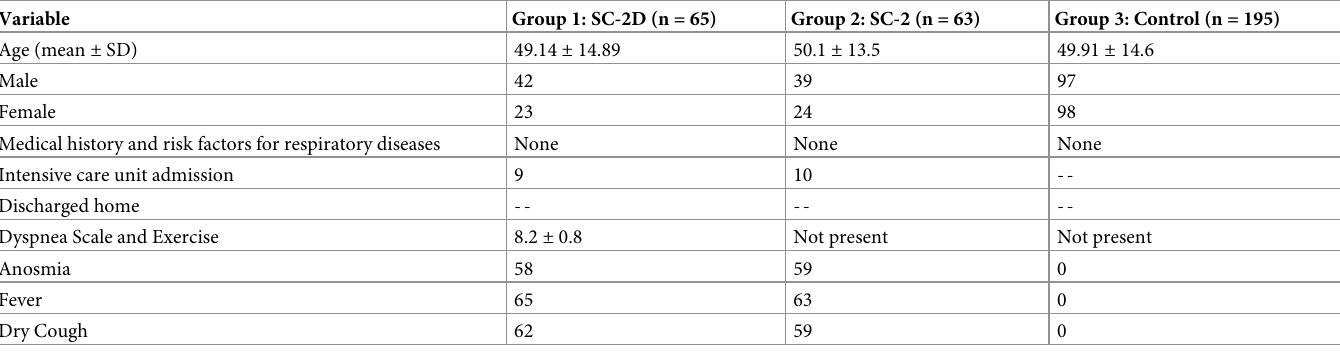
Table 1. Clinical characteristics of enrolled